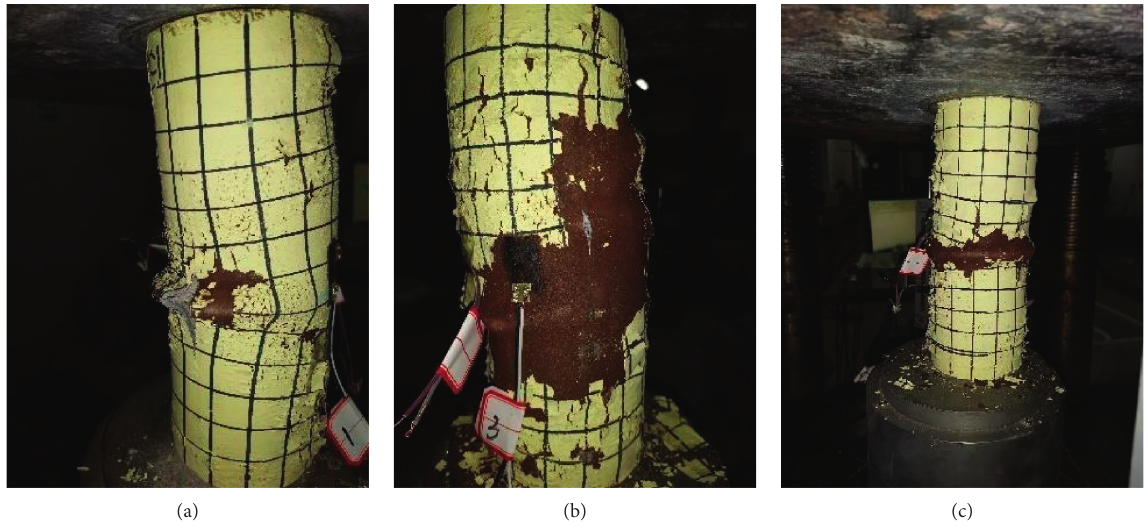
Figure 3: Typical failure modes of tested specimens. (a) C1. (b) C4. (c) C6.